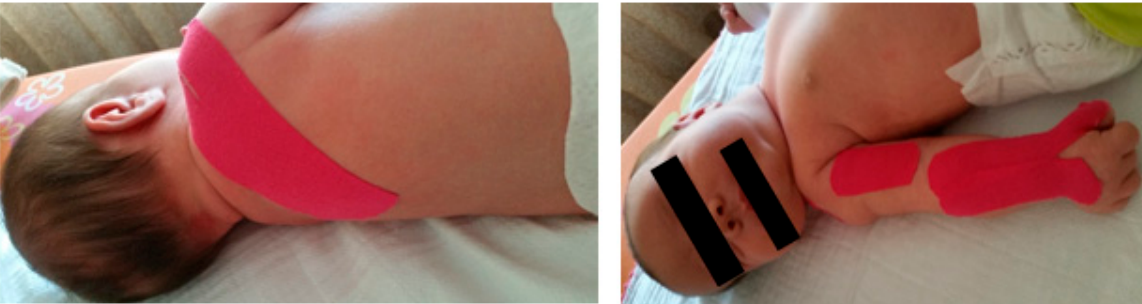
Figure 9. Kinesio Tape applied to different muscle groups.